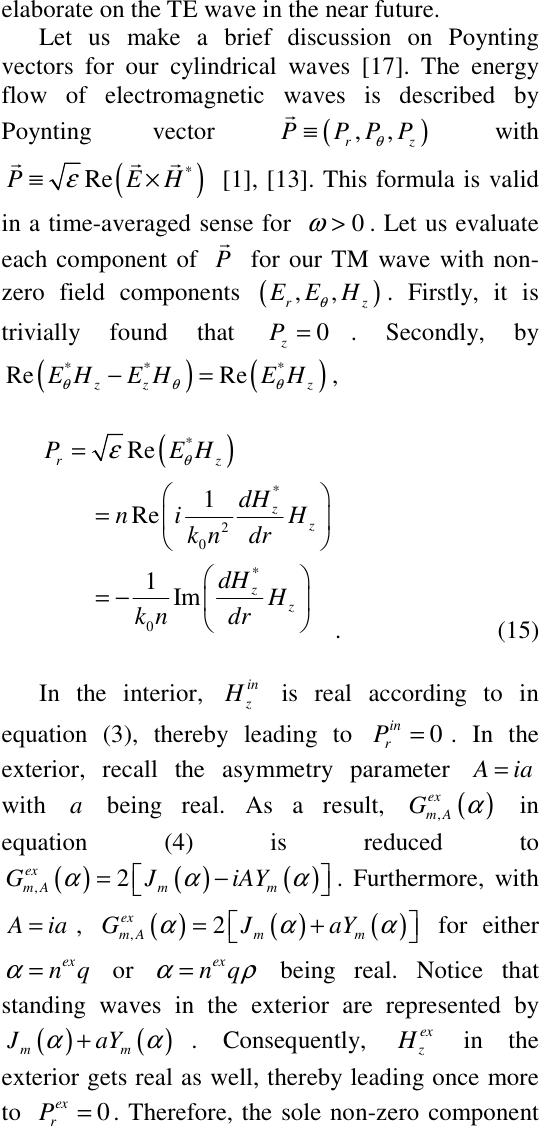
. Firstly, it is P = . Secondly, z